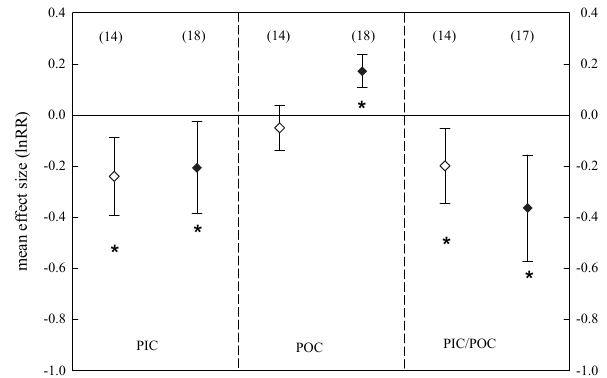
Figure 3. The effect of elevated CO 2 concentrations on the inor- ganic to organic carbon ratio of three coccolithophore species: Emil- iania huxleyi , Coccolithus braarudii and Gephyrocapsa oceanica (mean effect size and 95% confidence interval). Responses are rel- ative to 280 ppm. * indicates a significant response, which is given when the confidence interval does not overlap zero. The number of experiments included in the meta-analysis is shown in parentheses. The zero line indicates no effect.